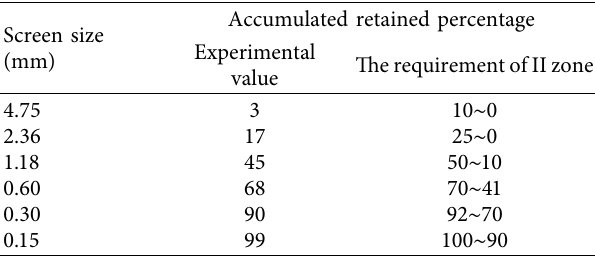
Table 2: The size distribution of